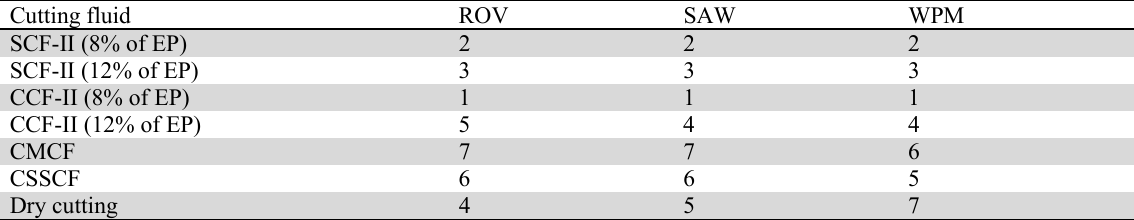
Rankings of the cutting fluids obtained using different MCDM methods Cutting fluid ROV SAW WPM SCF-II (8% of EP) 2